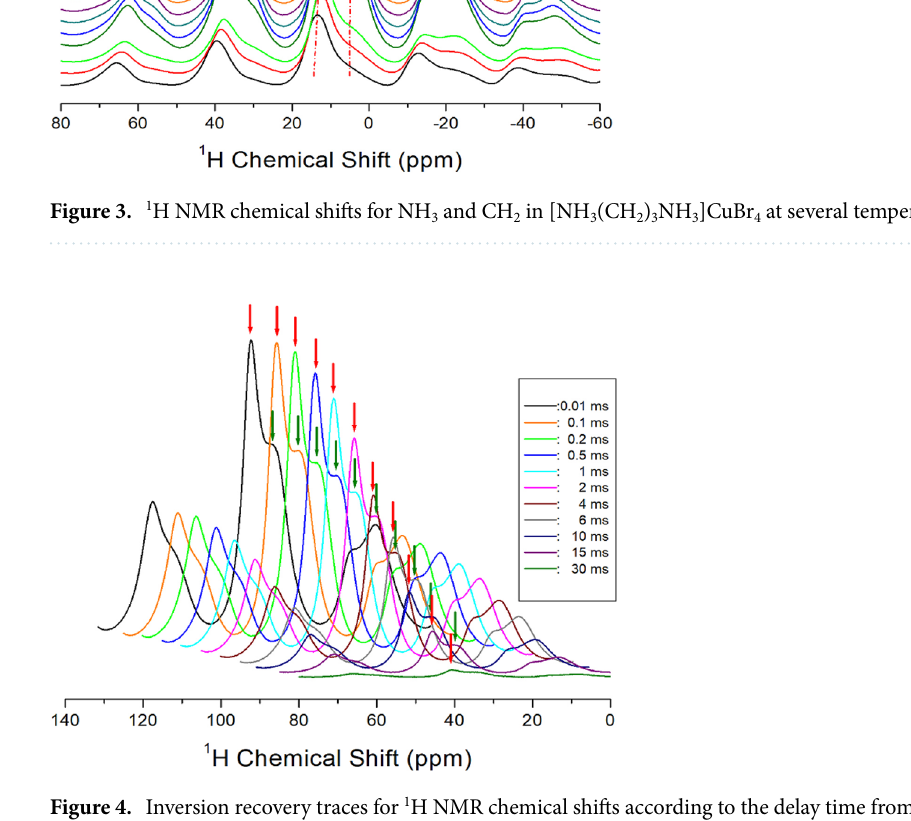
Figure 4. Inversion recovery traces for 1 H NMR chemical shifts according to the delay time from 0.01 to 30 ms at 300